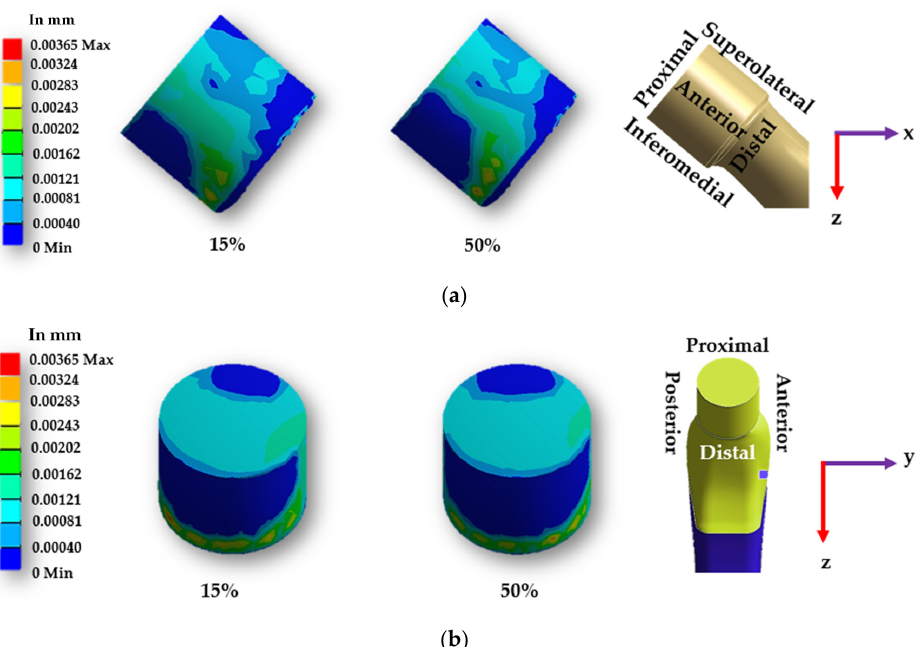
Figure 14. Sliding distance map over a smooth head-neck tapered joint from the ( a ) front and ( b ) right side for the walking loading condition.